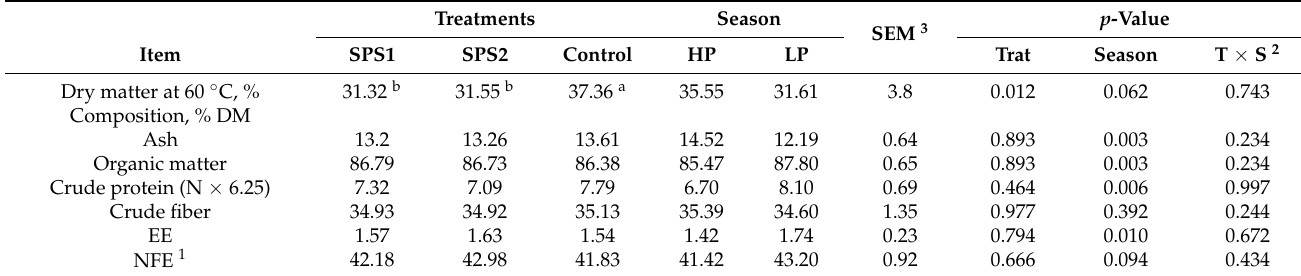
Table 2. Chemical composition of guinea grass Panicum maximum cv. Mombaça evaluated under different silvopastoral systems. Treatments